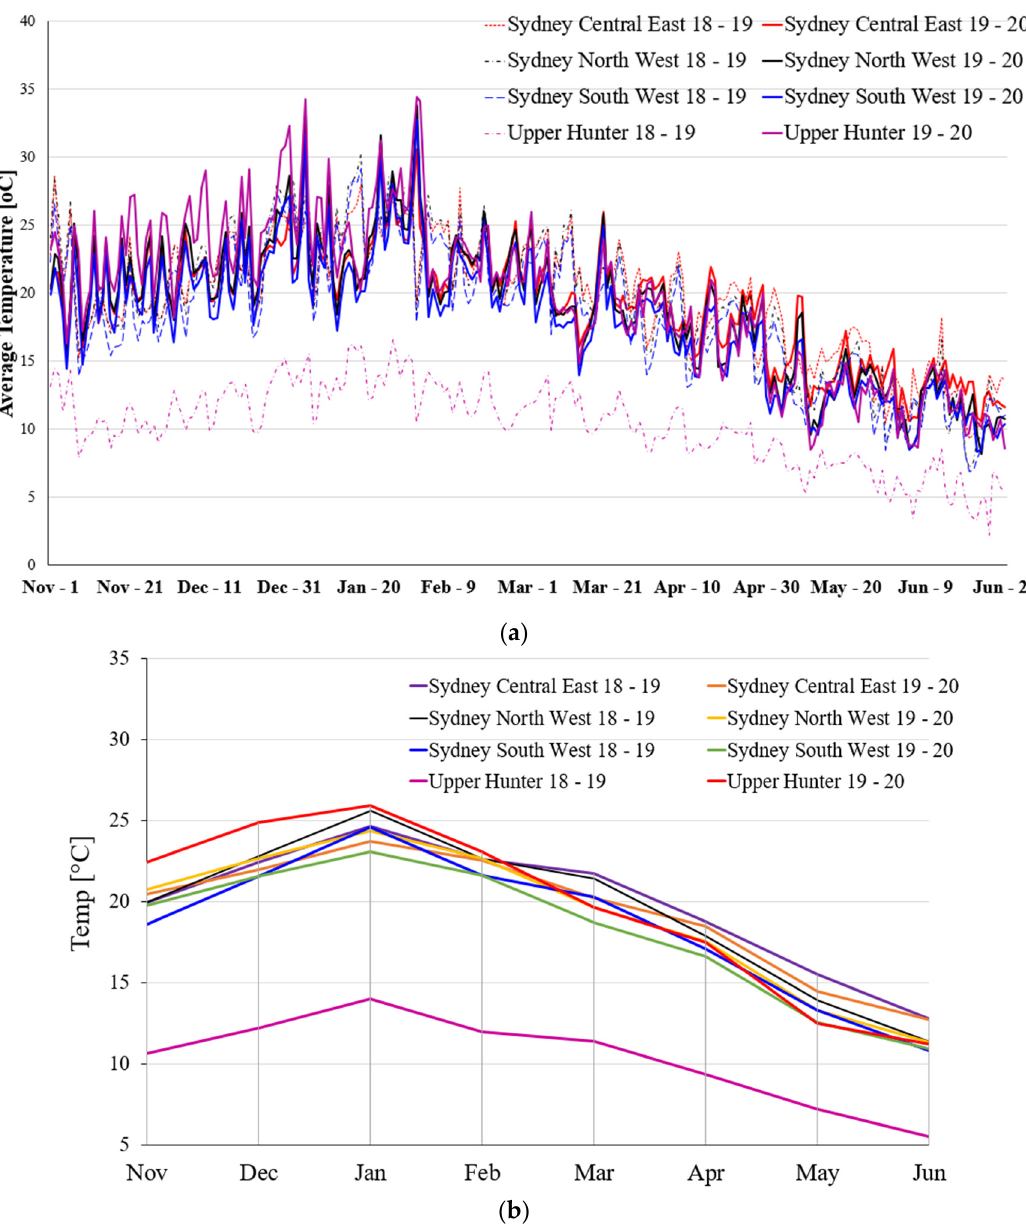
Figure 2. The average temperature (°C) in Sydney Central East, North West, South West, and Upper Hunter region for a period of eight months during 2018–2019 and 2019–2020, ( a ) daily average temperature, and ( b ) monthly average temperature.